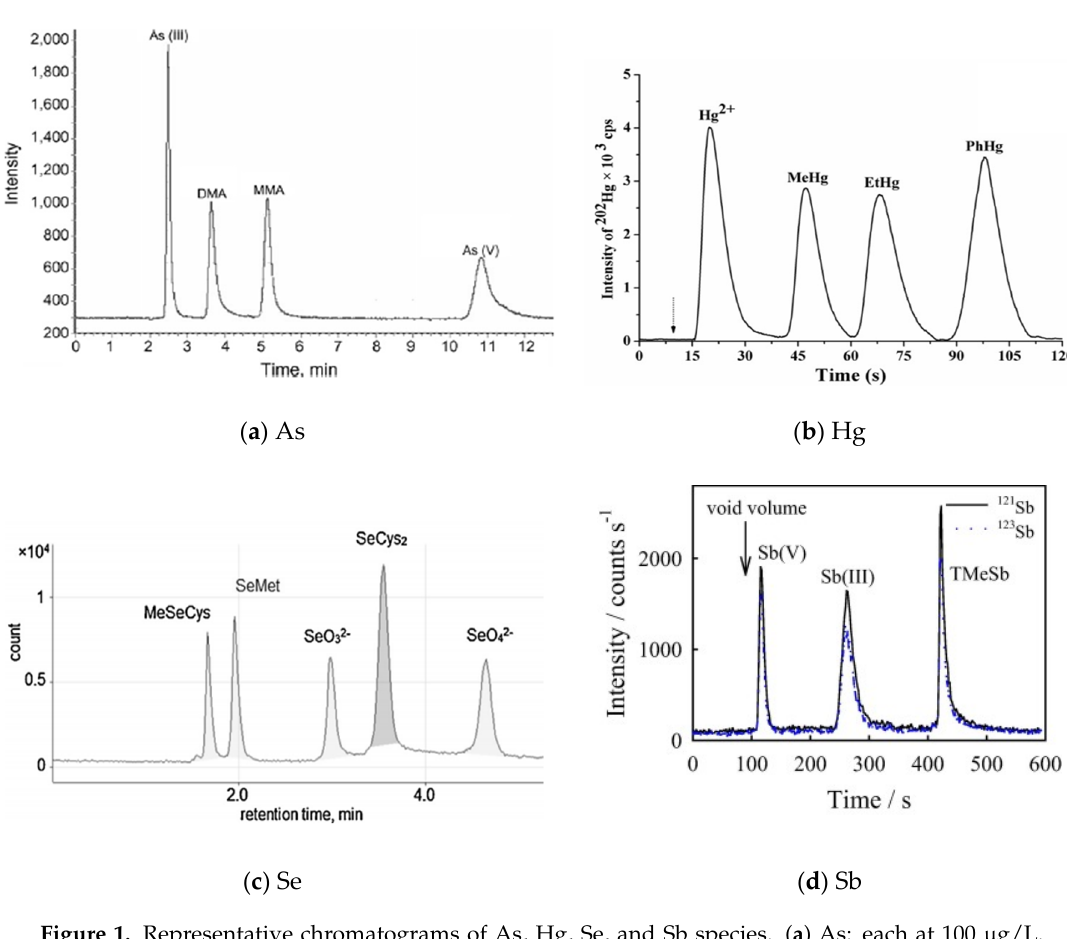
Figure 1. Representative chromatograms of As, Hg, Se, and Sb species. ( a ) As: each at 100 µg/L. Detected by HG-AFS after separated by a Hamilton PRP-X100 column (250 mm × 4.1 mm i.d., 10 µm) and eluted using 15 mM (NH 4 ) 2 HPO 4 (pH 6.0) at 1.0 mL/min flow rate [127]; ( b ) Hg: each at 5.0 µg/L. Detected by ICP-MS after separated by two consecutive Zorbax SCX columns (12.5 mm × 4.6 mm i.d., 5 µm) and eluted by 2.0 mM thiourea (pH 2.0) at 1.5 mL/min flow rate [128]; ( c ) Se: Detected by ICP-MS after separated by a Dinoex IonPac AS11 anion exchange column (4 mm i.d. × 250 mm) and eluted using 10 mM NaHCO 3 with 2% acetonitrile (pH 11 adjusted with 20% NH 3 ) at 0.6 mL/min flow rate [129]; ( d ) Sb: 1 µg/L Sb(V), 2 µg/L Sb(III) and TMeSb. Detected by ICP-MS after separated by a Hamilton PRP-X100 column (250 × 4.1 mm i.d., 10 µm) and eluted using A: 20 mM EDTA + 2 mM KHP (pH 5.5), B: 20 mM + 2 mM KHP + 40 mM (NH 4 ) 2 CO 3 + 1% ( v / v ) CH 3 OH (pH 9.0) at 1.2 mL/min flow rate [123].